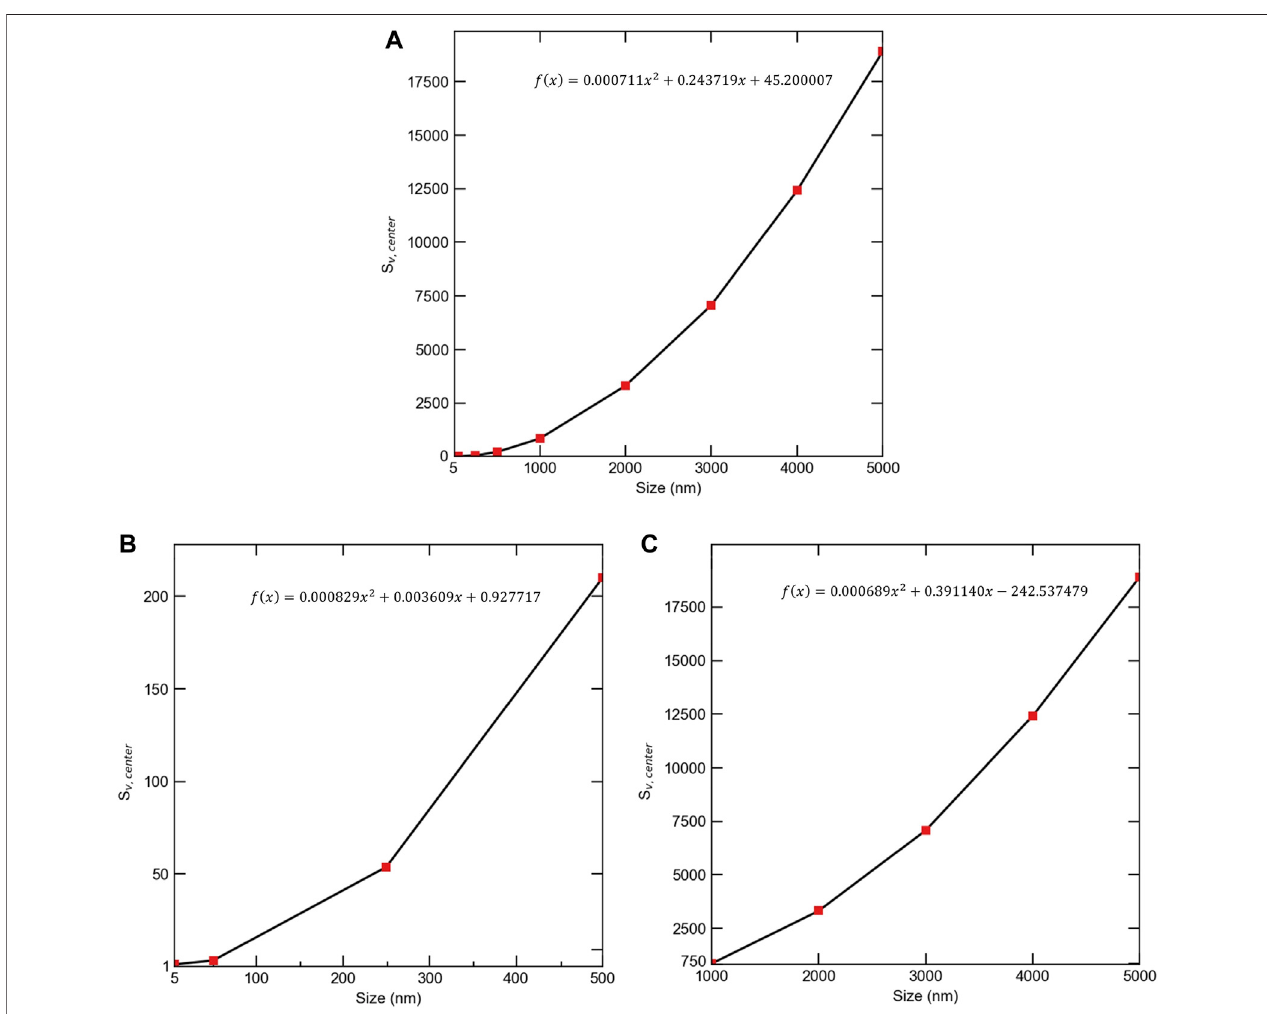
FIGURE8| Theeffectofsizeonmaximumvacancysupersaturationatadoserateof1e-6 dpa/sand5%productionbias. (A) wholesizerange, (B) submicronsizes (C) micro sizes. The maximum vacancy supersaturation increases with grain size and the rate of increase also rises with grain size. The effect of grain size is more pronounced above the critical size (1,000 nm). The fi tting equations are valid for sizes between 5 and 5,000 nm.